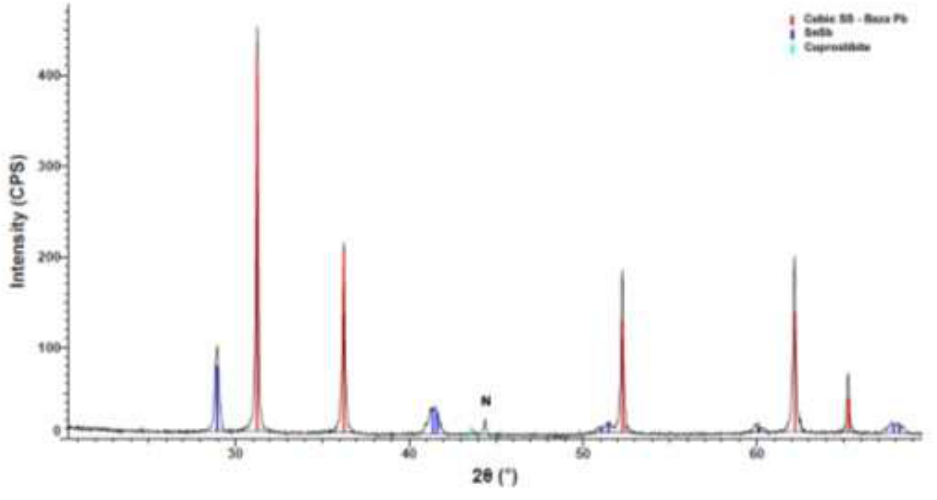
Figure 4. XRD pattern of the YP1 sample.